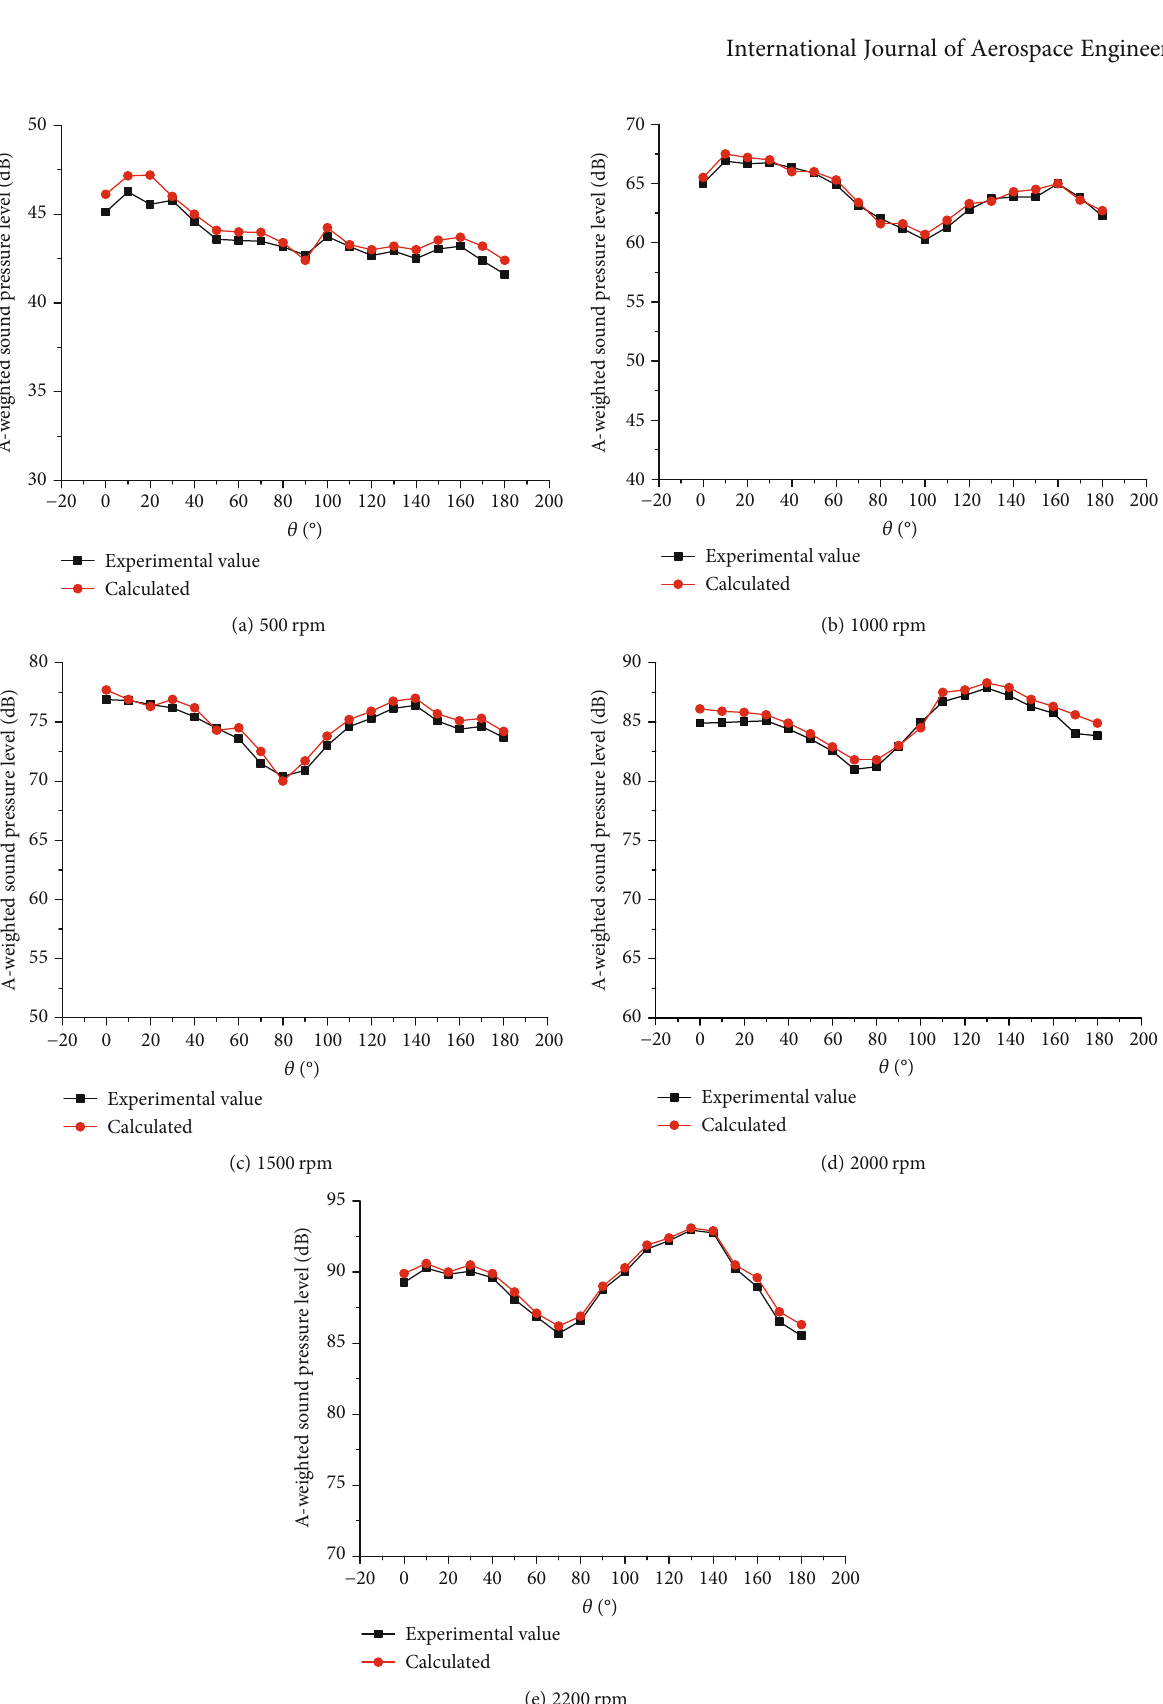
Figure 6: Noise pressure level distribution under each rotating